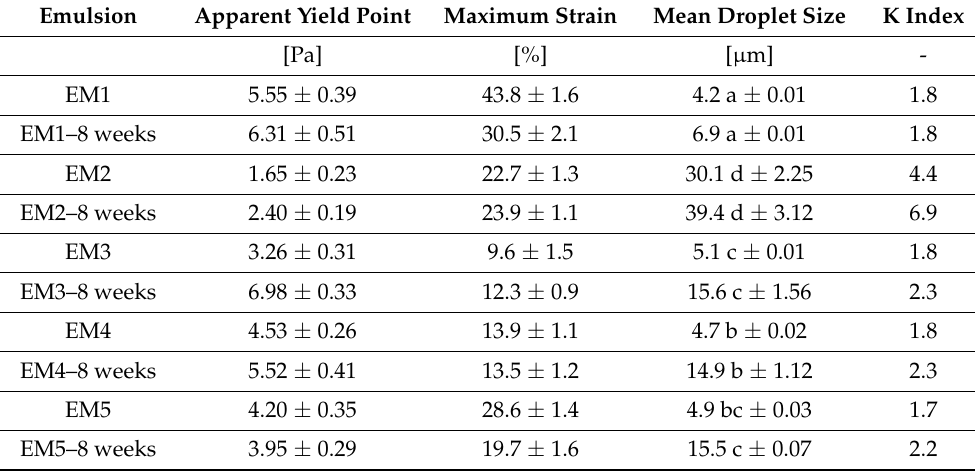
Table 2. Apparent yield point values and maximum strains of the investigated materials compared to mean droplet size and K indexes. Emulsion Apparent Yield Point Maximum Strain Mean Droplet